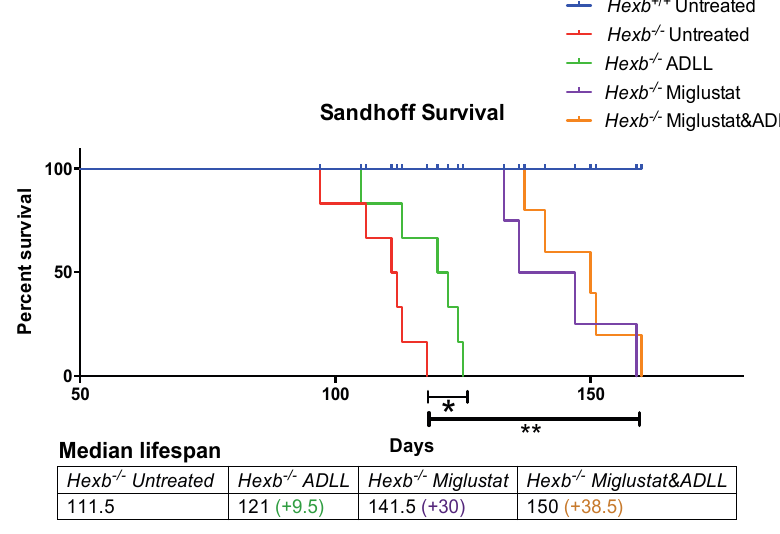
Figure 5. Evaluation of lifespan in miglustat alone or miglustat plus ADLL combination therapy in Hexb -/- mice. Wild-type ( Hexb +/+ ) untreated (blue line), n = 5; Sandhoff ( Hexb -/- ) untreated (red line), n = 6; Sandhoff ( Hexb -/- ) ADLL treated (green line), n = 6; Sandhoff ( Hexb -/- ) miglustat treated (purple line), n = 4; Sandhoff ( Hexb -/- ) miglustat and ADLL treated (orange line), n = 5; changes in life expectancy (%). Mean ± SD, * p = 0.0247, ** p < 0.0039 (log-rank test). Median survivals are indicated in the table.